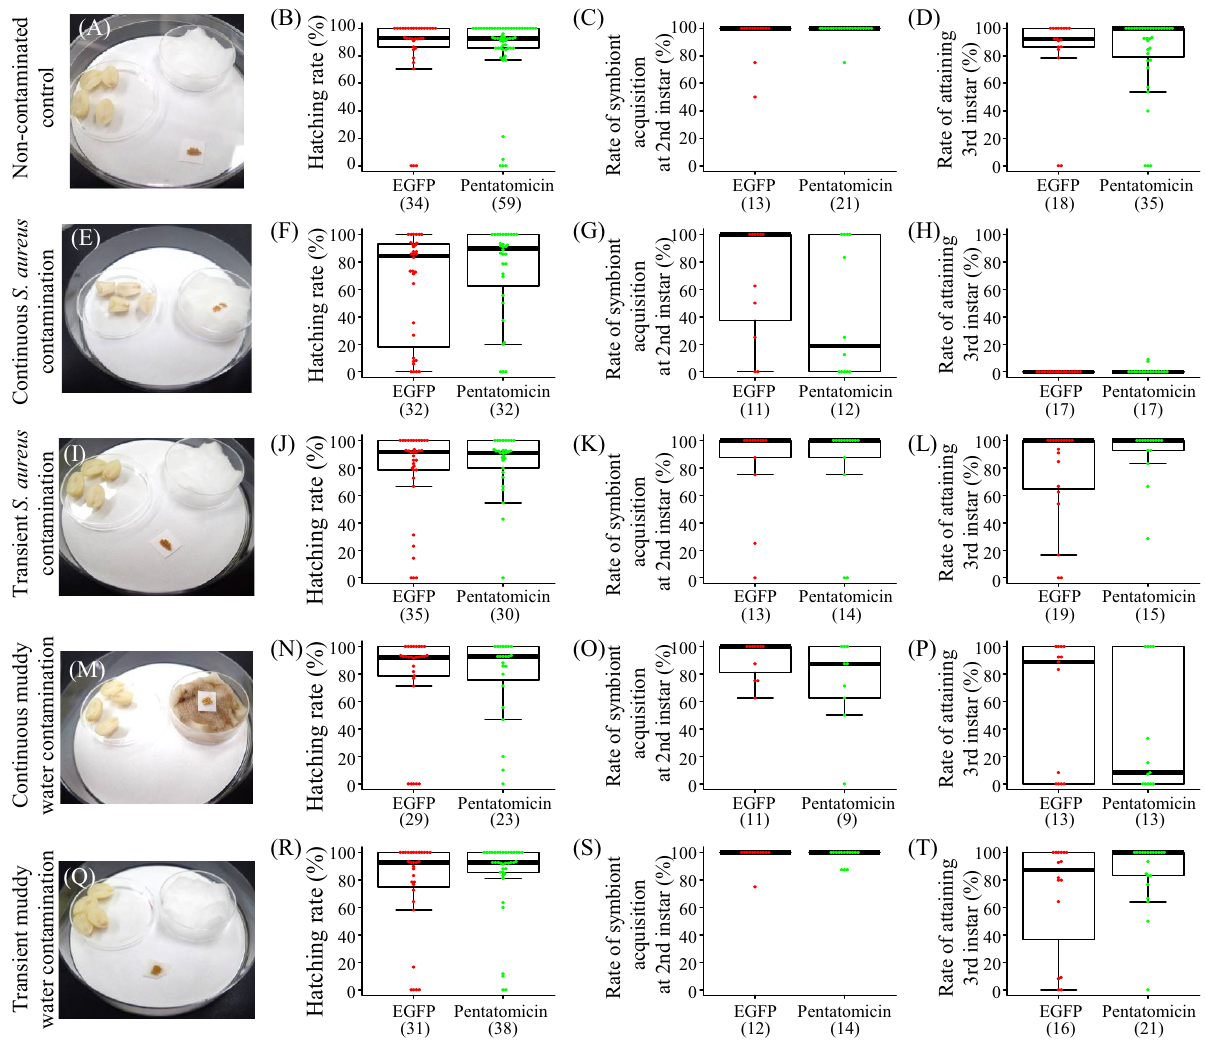
Figure 6. Effects of maternal RNAi of Pentatomicin on egg hatching, symbiont transmission and nymphal development under a variety of contaminating conditions. ( A – D ) Non-contaminated control, in which eggs were placed in a clean dish with sterilized water and peanuts. ( E – H ) Continuous S. aureus contamination, in which eggs were placed on liquid culture medium of S. aureus in a clean dish with sterilized peanuts. ( I – L ) Transient S. aureus contamination, in which eggs were soaked in liquid culture medium of S. aureus and then placed in a clean dish with sterilized water and peanuts. ( M – P ) Continuous muddy water contamination, in which eggs were placed on muddy water in a clean dish with sterilized peanuts. ( Q – T ) Transient muddy water contamination, in which eggs were soaked in muddy water and then placed in a clean dish with sterilized water and peanuts. ( A , E , I , M , Q ) Photographs of treated eggs. ( B , F , J , N , R ) Hatching rate. ( C , G , K , O , S ) Rate of symbiont acquisition at 2nd instar. ( D , H , L , P , T ) Rate of attaining 3rd instar. These rates were calculated in each egg mass and the number of egg masses is given in parentheses. In all the treatments, no statistically significant differences were observed between Pentatomicin-suppressed eggs and dsEGFP-injected control eggs for the hatching rates, symbiont acquisition rates, and rates of attaining 3rd instar (Mann–Whitney U